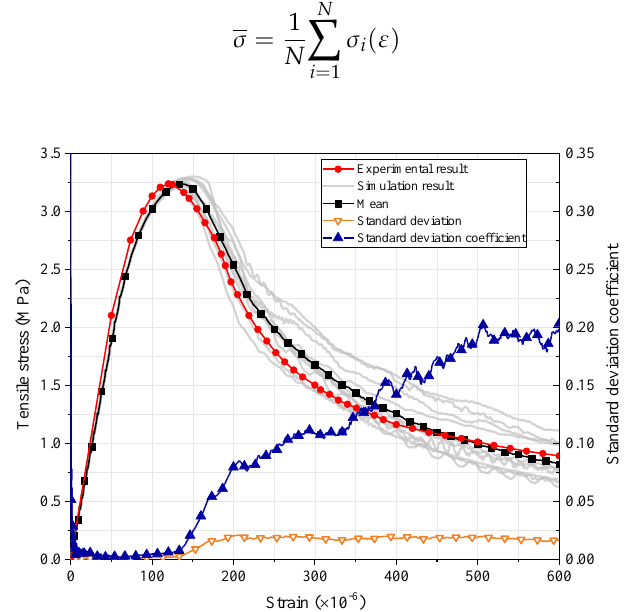
Figure 7. Statistical characteristic of global stress-strain curve under tension.